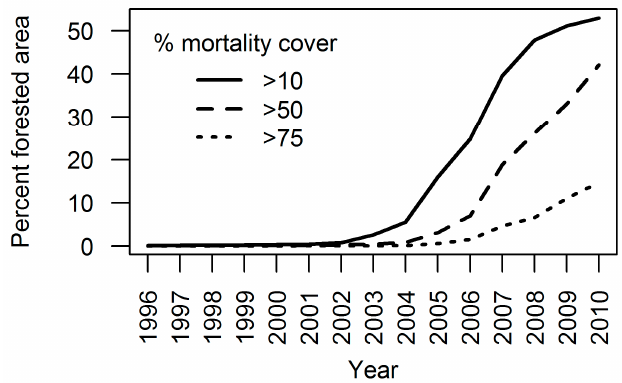
Figure 2. Progression of percent tree mortality cover detected by the Landsat time series product of Meddens and Hicke [68] for 30-m forested pixels across the study area.